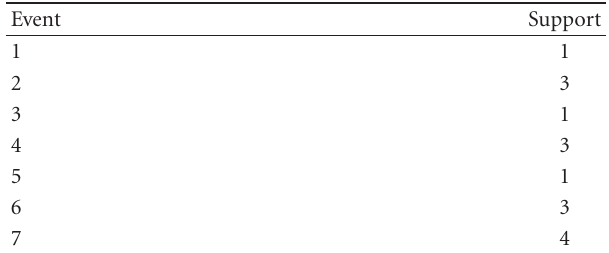
Table 3: Candidate event set.